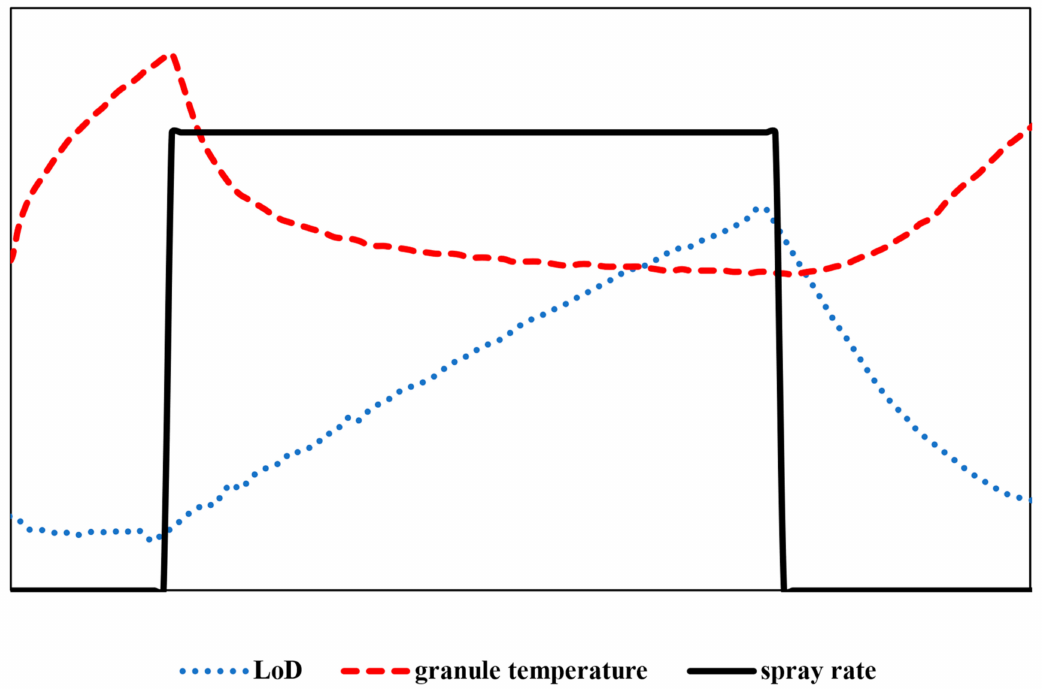
Figure 3. Temporal evolution of temperature and granule LoD for a typical granulation process.